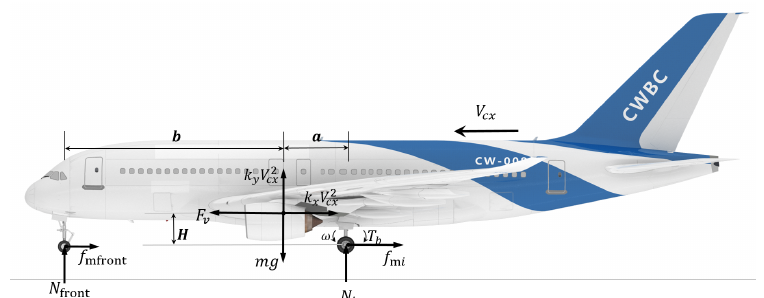
Figure 1. Force analysis of